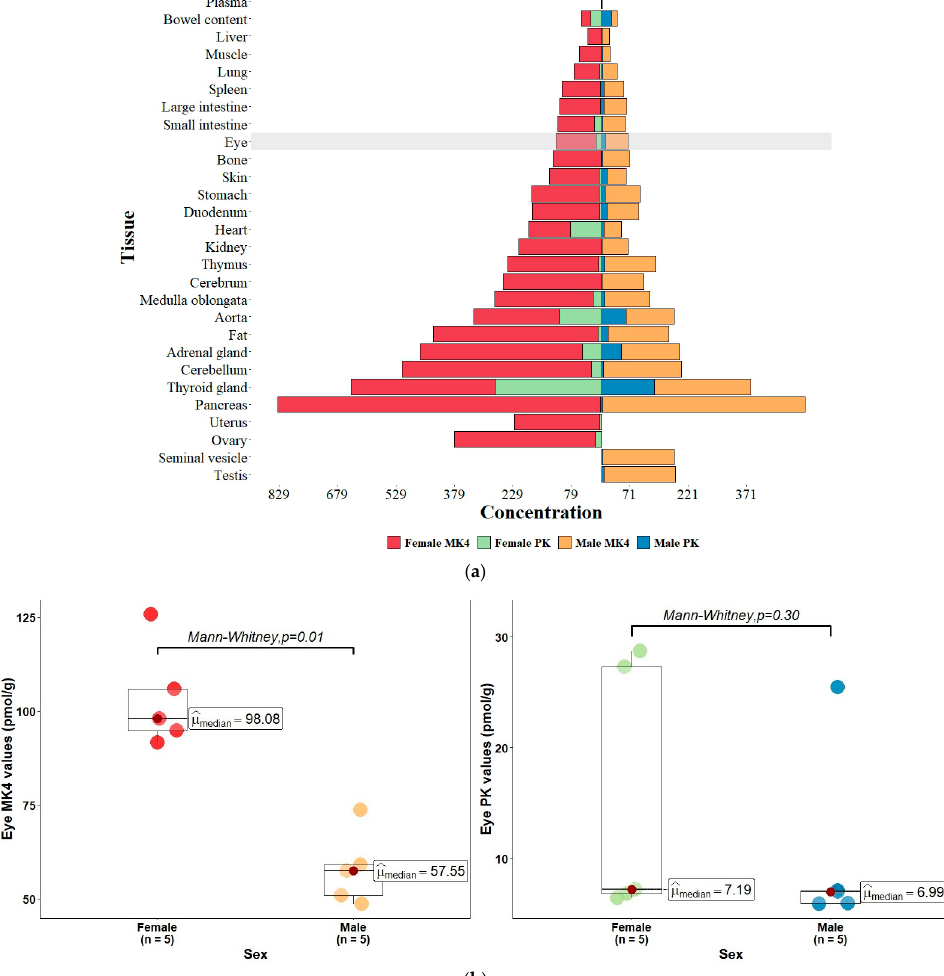
Figure 3. ( a ) Mean ( n = 5) tissue MK4 and PK concentration (pmol/g tissue or pmol/mL plasma) in mice fed a normal diet sorted by female MK4 concentration. Red—female MK4; Green—female PK; Orange—male MK4; and Blue—male PK. Note tissue type, gender, female/male MK and PK ratios, as well as tissue type and gender MK/PK. ( b ) Box plots of MK4 and PK concentrations across sex in mice. Mann–Whitney U test used to obtain p values. MK4 p = 0.01, PK p = 0.3. Adapted from [55]. (CC BY license h tt ps:// creativecommons.org/licenses/by/3.0/. Table 1 of original work reforma tt ed to re fl ect relative eye MK4 and PK tissue concentrations. No endorsement is implied.)